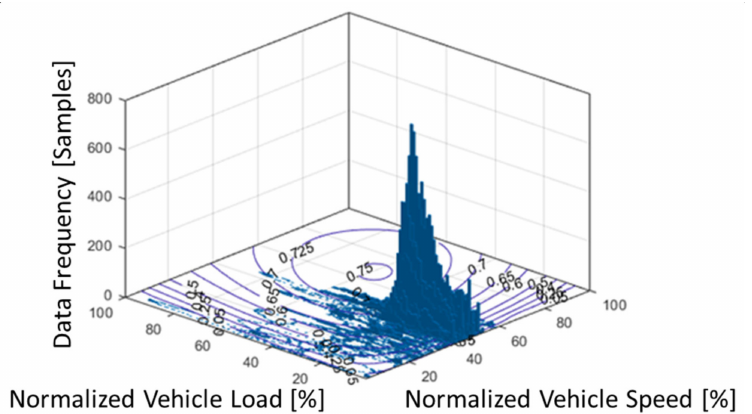
Figure 16. Frequency Representative of the Instances of Vehicle Operation in the HT Efficiency Map—Reference System.